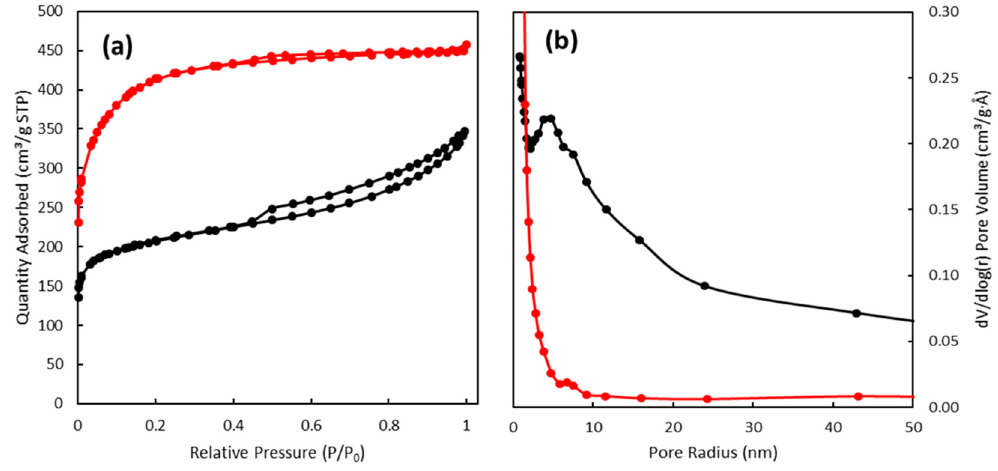
Figure 2. Textural characteristic of used sorbents Norit and SuperSorbon. ( a ) The iso- therm of physical nitrogen adsorption. ( b ) Distribution of mesopores from the adsorption branch of the isotherm of physical nitrogen adsorption.